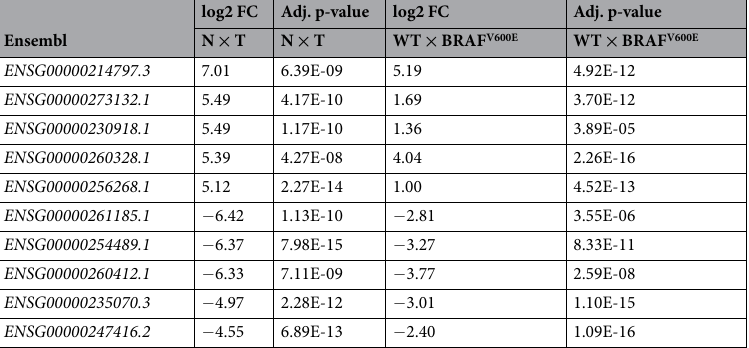
Table 1. Top 5 upregulated and 5 downregulated common DE lncRNAs between Normal × Tumor and WT × BRAF V600E